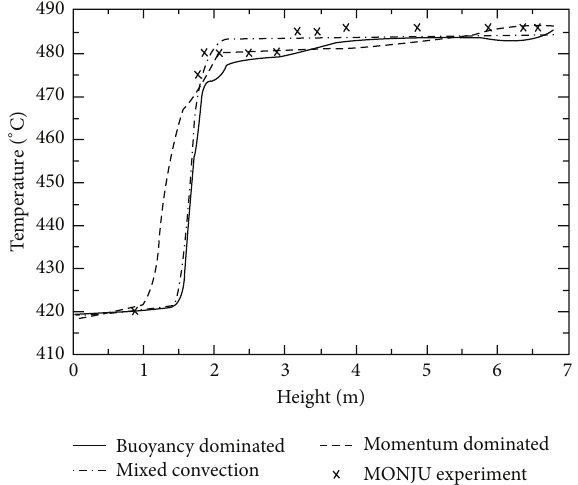
Figure 6: Comparison of the axial temperature profiles.